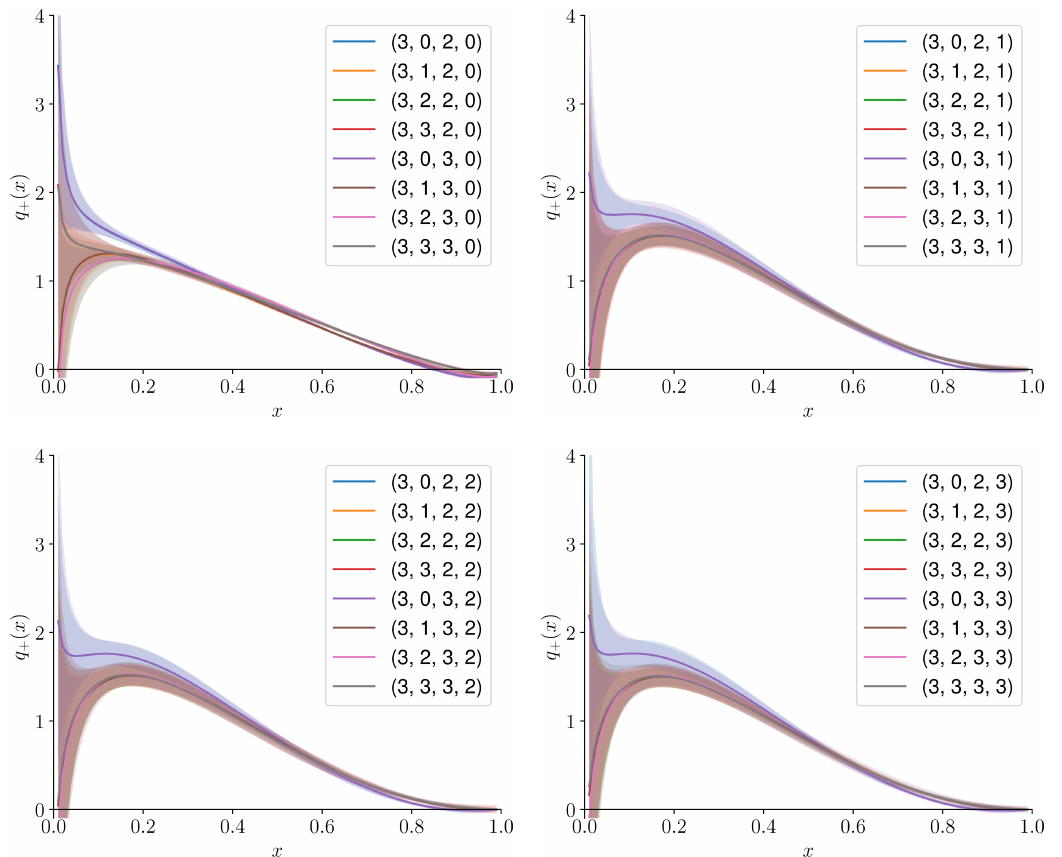
Figure 19 . The PDF results from fitting the imaginary component to the models. The numbers in the legend correspond to ( N ± , N